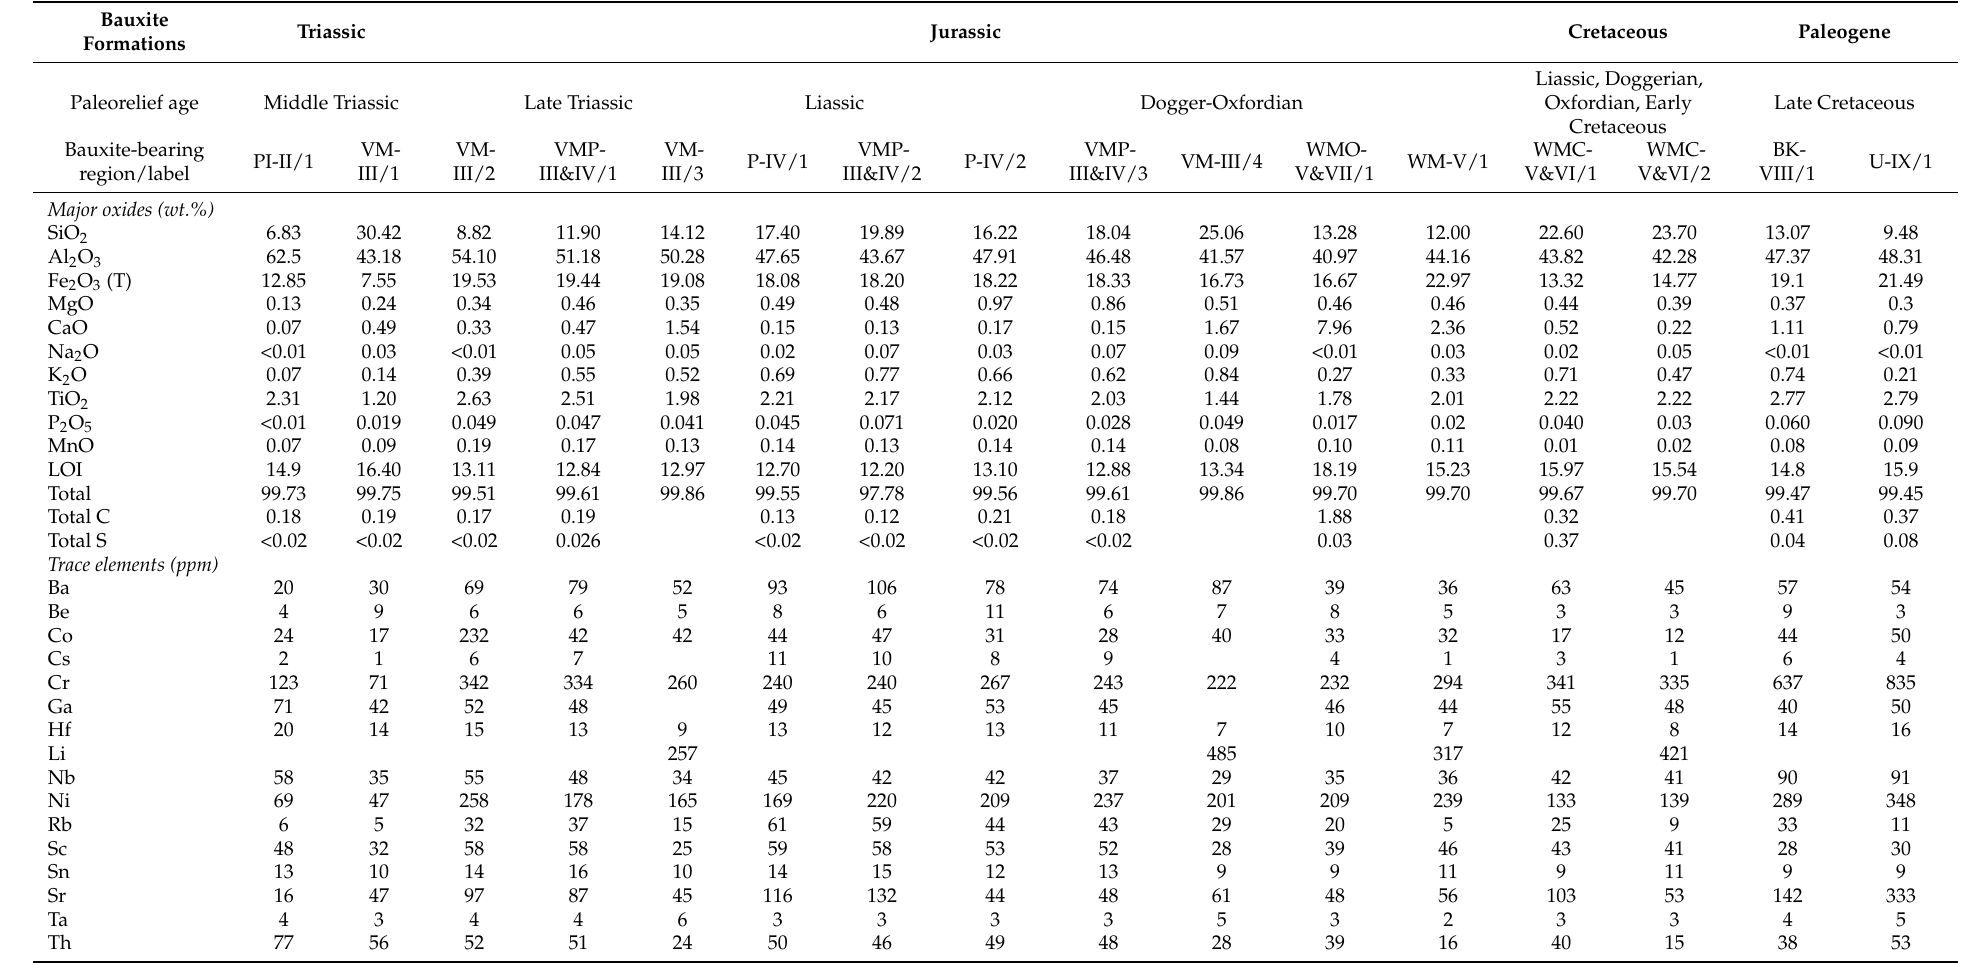
Table 4. Major-, trace- and rare earth element average compositions of the analysed samples (Radusinovi´c [5]; REEBAUX